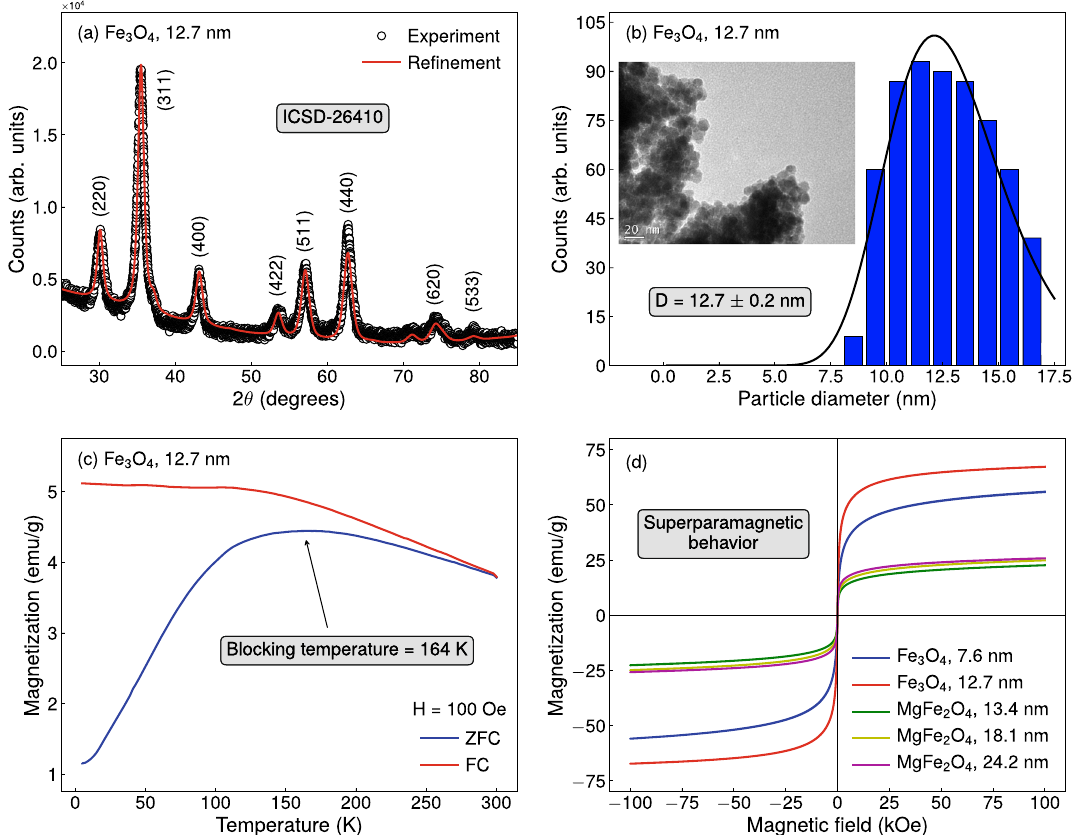
Figure 4. Structural, morphological and magnetic properties of our magnetite and magnesium ferrite nanoparticles. ( a ) X-ray diffraction pattern with Rietveld refinement, ( b ) transmission electron microscopy image with histogram of particle size distribution fitted with a log-normal function, and ( c ) ZFC and FC magnetization curves acquired with probe magnetic field of 100 Oe for the magnetite sample with average particle diameter of 12.7 nm, as representative examples of our findings for the investigated nanoparticles. ( d ) Isothermal magnetization curves measured at room temperature for the magnetite and magnesium ferrite samples with distinct particle